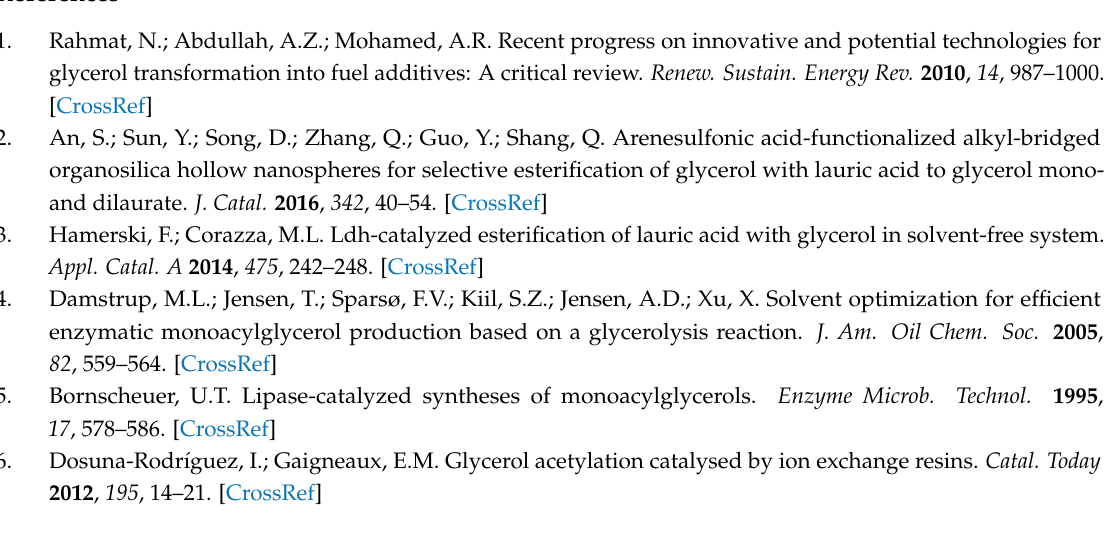
Figure S1: Effect of aminosilane functionalization on catalyst reusability using S-N 2 -HPW and S-HPW catalysts in esterification of glycerol with oleic acid for six cycles at 160 ◦ C for 3 h per cycle with 2.5 wt % of catalyst loading and glycerol/oleic acid molar ratio of